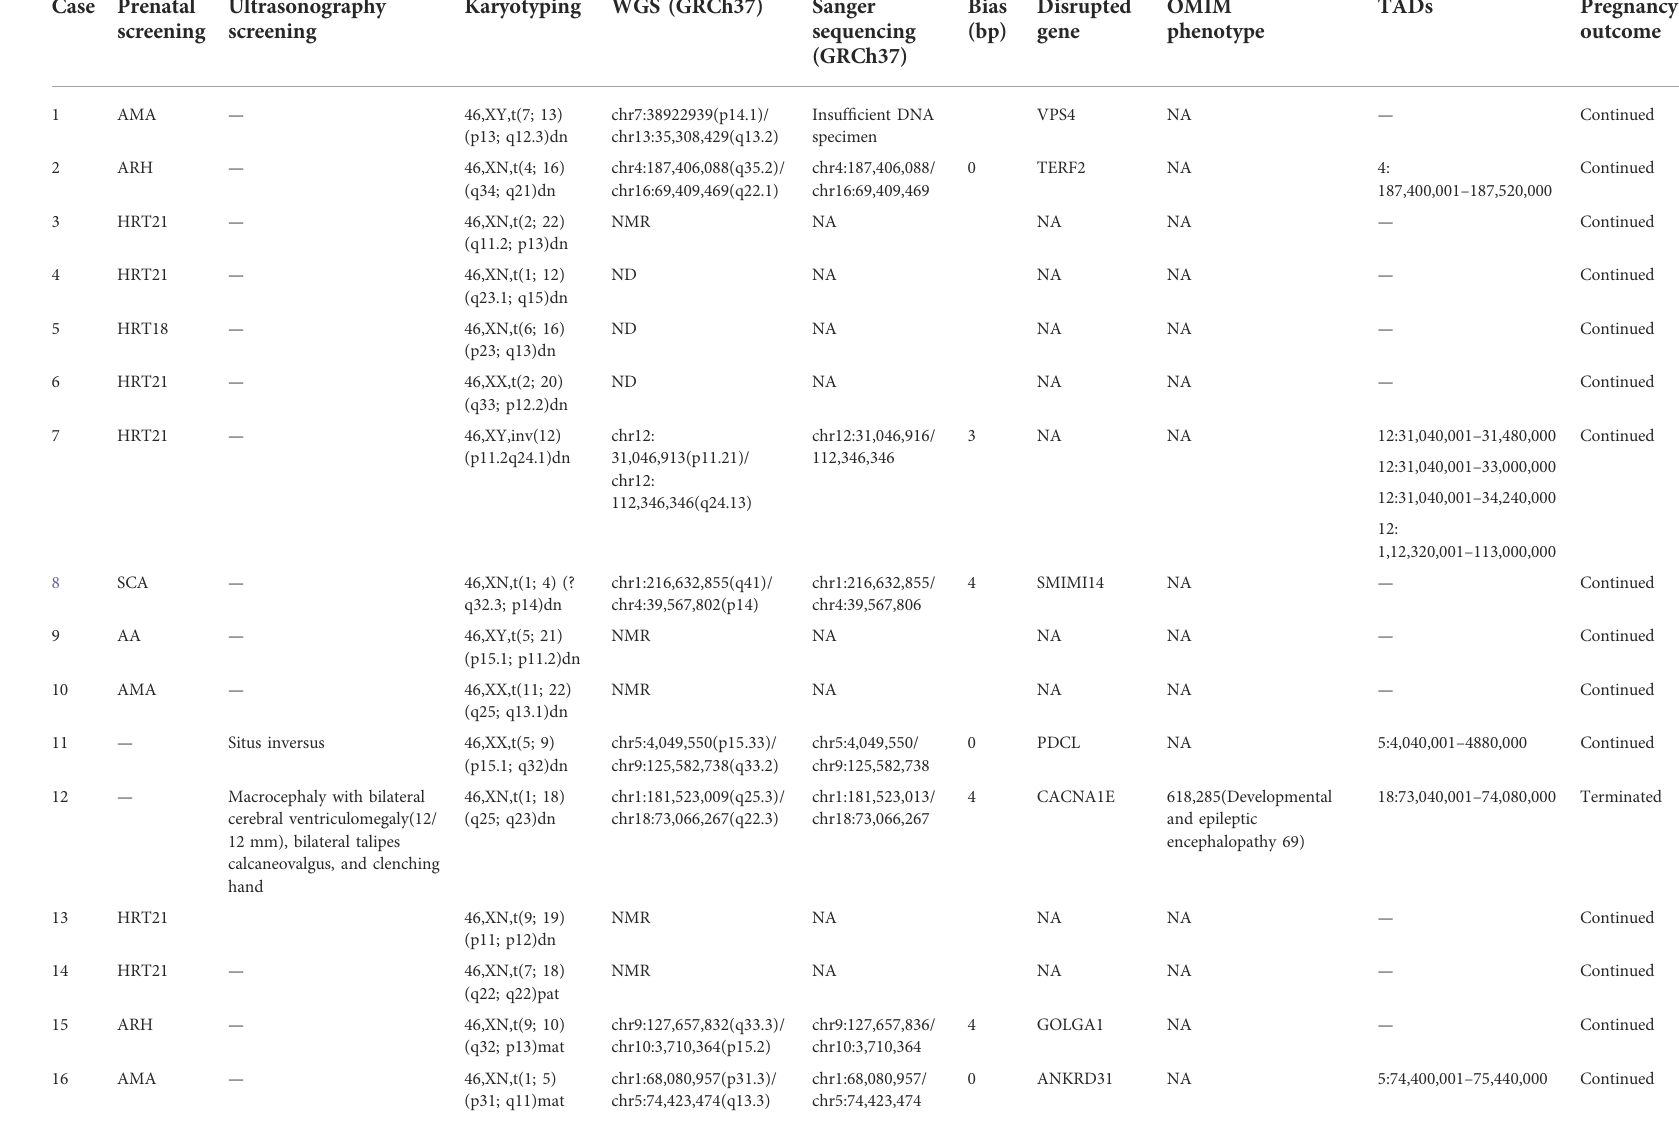
TABLE 1 Prenatal fi ndings and the parents ’ decision after genetic counseling based on the genetic tests in 21 cases. Case Prenatal Ultrasonography screening